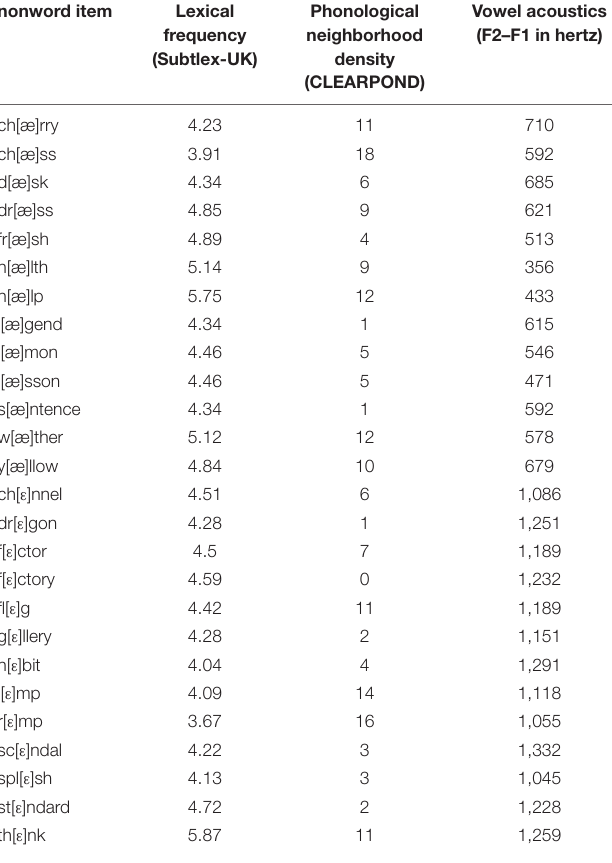
TABLE 1 | Lexical frequency, phonological neighborhood density, and F2–F1 values of the critical vowels for each of the / ε /- and /æ/-nonwords analyzed in the present